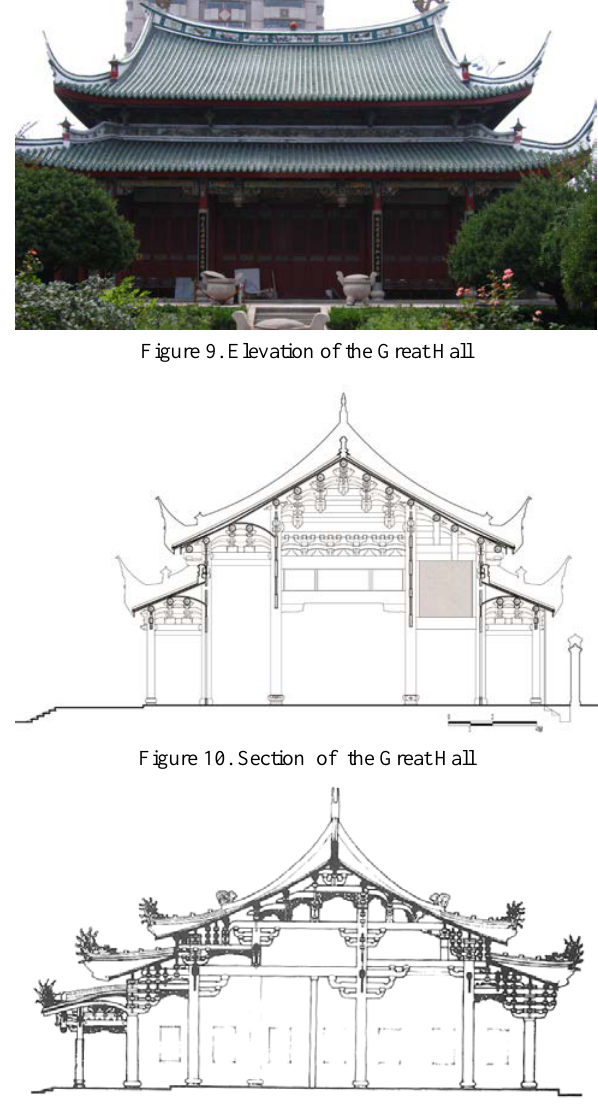
Figure 11. Section of the Palace of Tianhou in